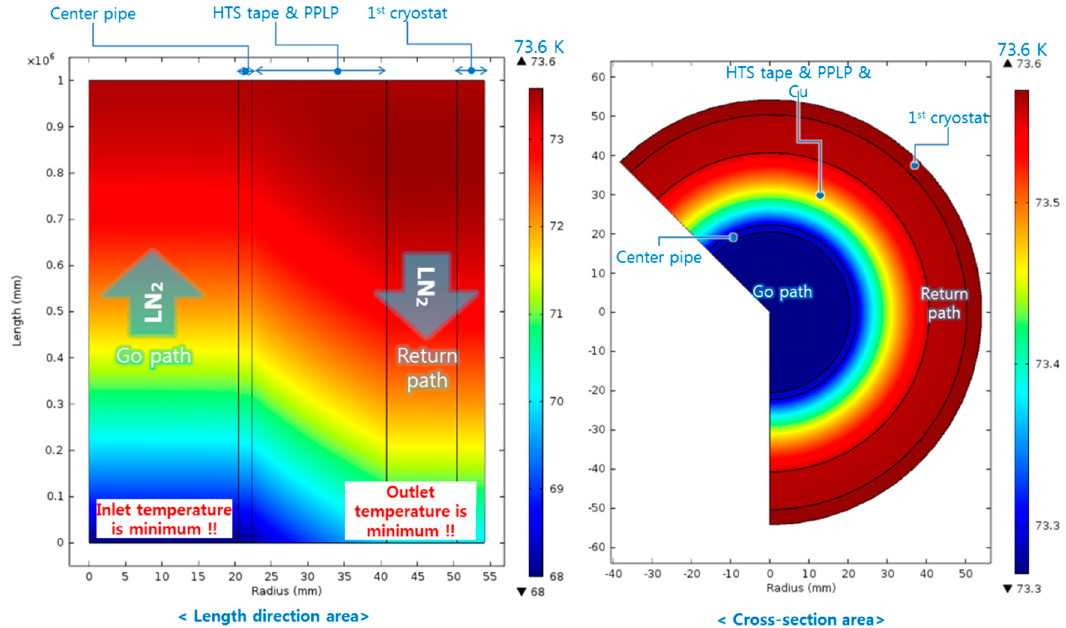
Figure 6. Temperature analysis results of length direction and the cross section of Case II (1 km).